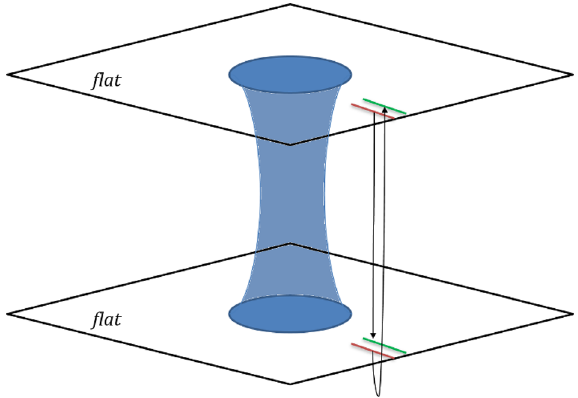
Figure 6 . Replica trick without replica wormhole for n = 2 replicas.